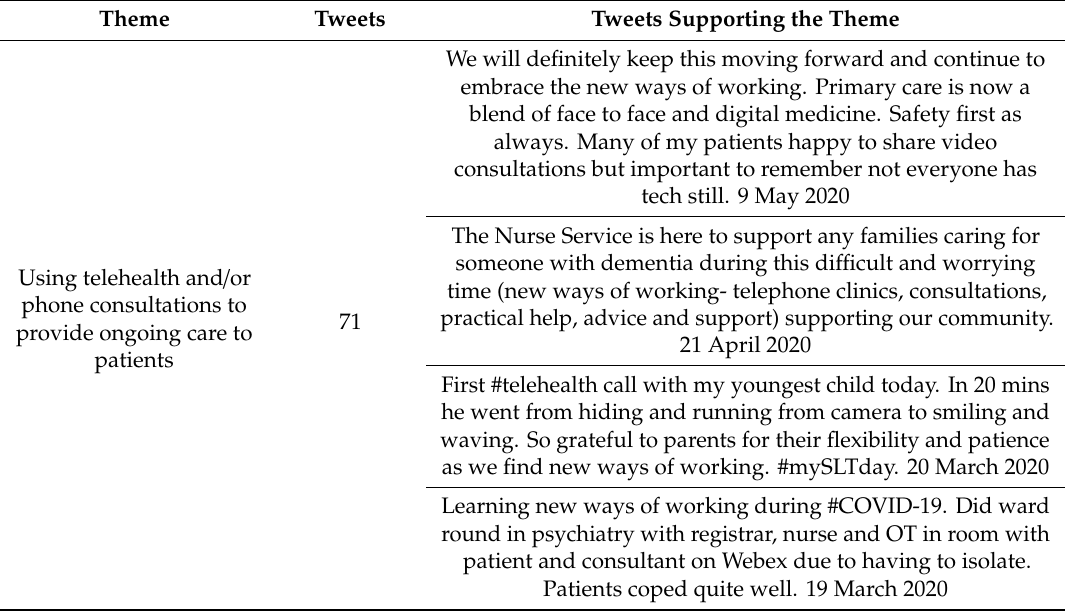
Table 2. Main Themes Supported by